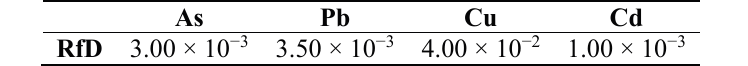
Table 2. The oral reference dose (RfD) for heavy metals in food (mg/(kg·d)).